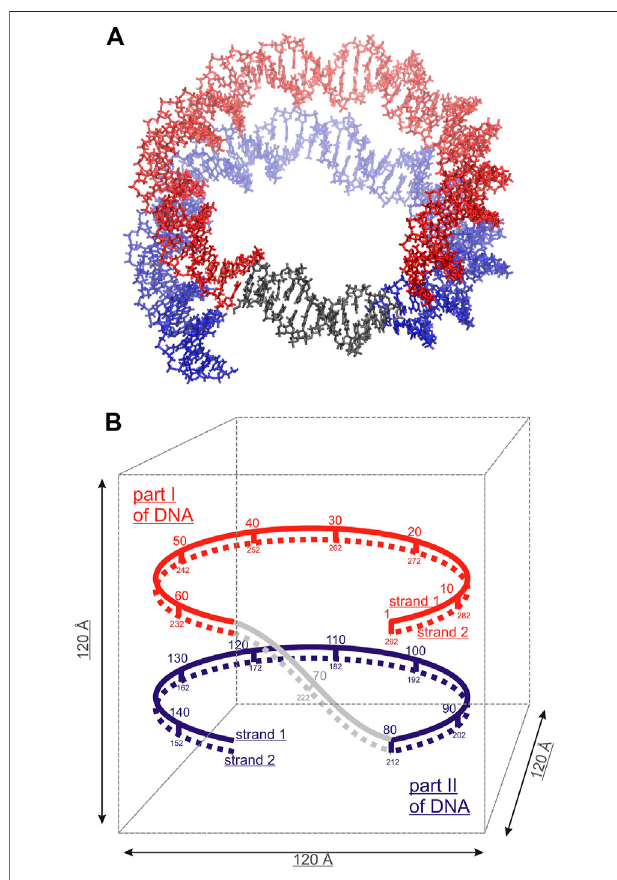
FIGURE 2 | Simulated system of nucleosomal DNA. (A) Licorice representation of the nucleosomal DNA: red and blue colors indicate the overlappingpartsoftheDNAdoublehelix,non-overlappingDNAcoloredgrey. (B) Schematic structure of the nucleosomal DNA in the simulation box. The numbering of the nucleotide pairs is